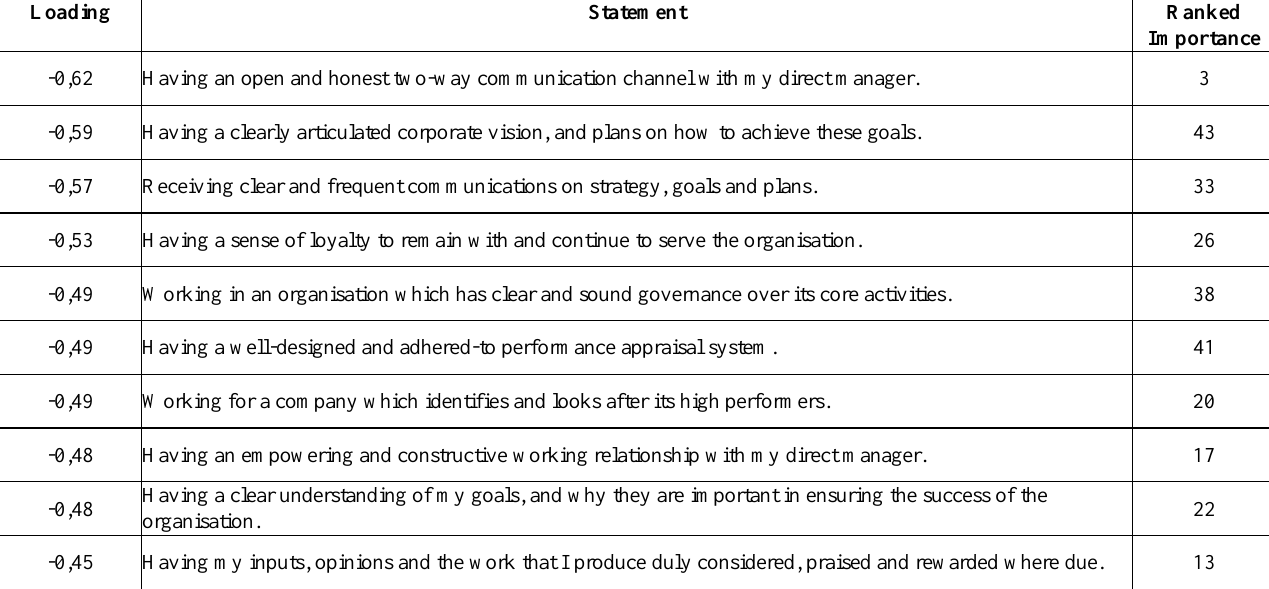
Table 5: Variables associated with factor three Loading